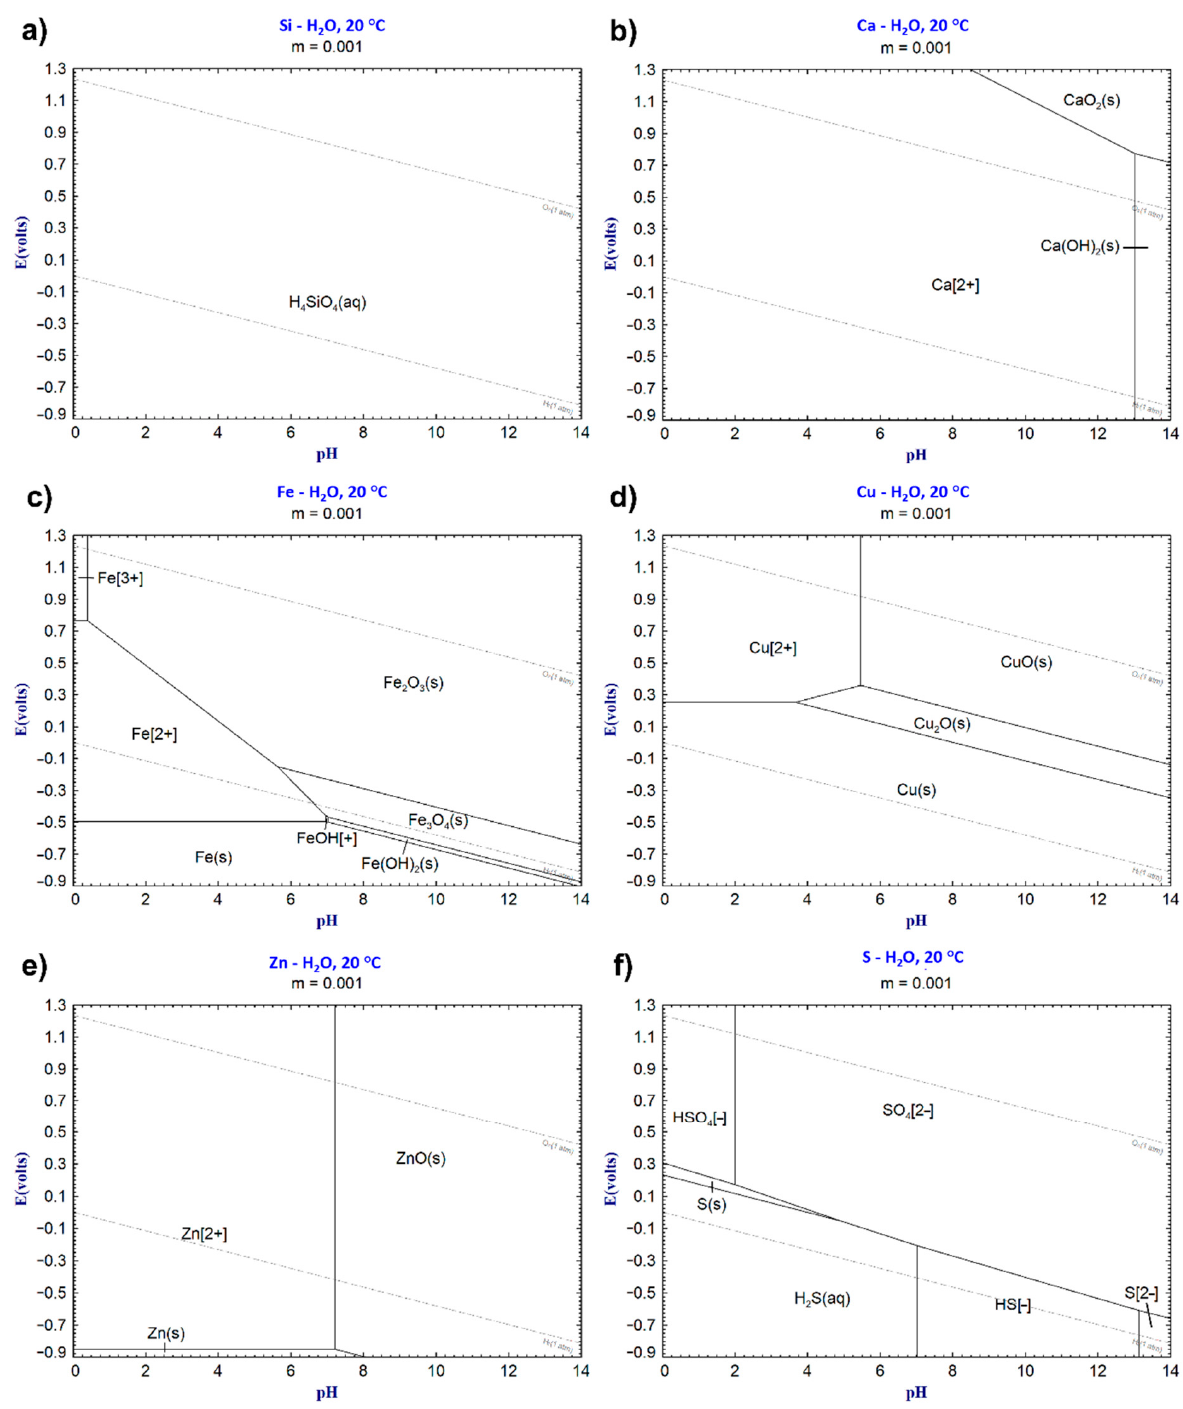
Figure 9. Predominant phase diagrams of ( a ) Si, ( b ) Ca, ( c ) Fe, ( d ) Cu, ( e ) Zn, and ( f ) S plotted using FactSage 8.1.